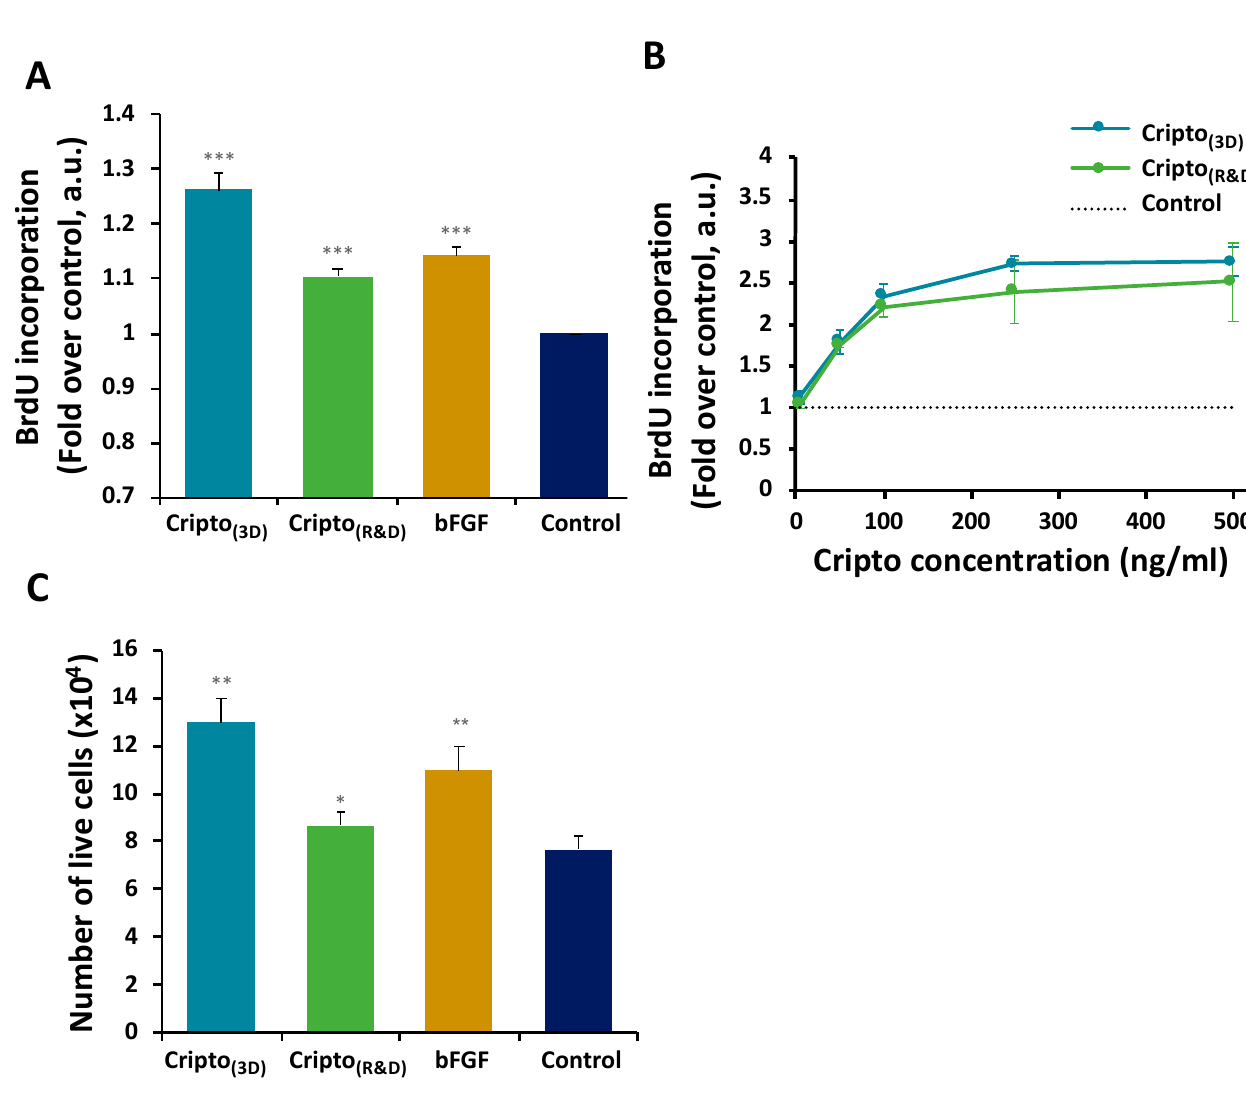
Figure 4. The effect of Cripto produced in 3D microcarriers on C2C12 cell proliferation detected by the BrdU incorporation assay. ( A ) C2C12 myoblast proliferation was evaluated by the BrdU incorporation assay after being cultured for 48 h in serum-free medium containing Cripto produced in 3D microcarriers (Cripto (3D) ) or commercially available Cripto (Cripto (R&D) ). Also evaluated were a bFGF medium positive control and a serum-free medium negative control. ( B ) The recombinant Cripto induces myoblast proliferation in a dose-dependent pattern; increasing concentrations of Cripto (3D) and Cripto (R&D) were added to C2C12 cells, and proliferation was quantified by the BrdU incorporation assay. ( C ) Cell proliferation was further evaluated by counting the total number of live cells. The proliferative effect of Cripto (3D) was compared with that of commercial Cripto (R&D) . The data are presented as mean ± S.D. from at least three independent experiments. * indicates p < 0.05, ** indicates p < 0.01, *** indicates p <